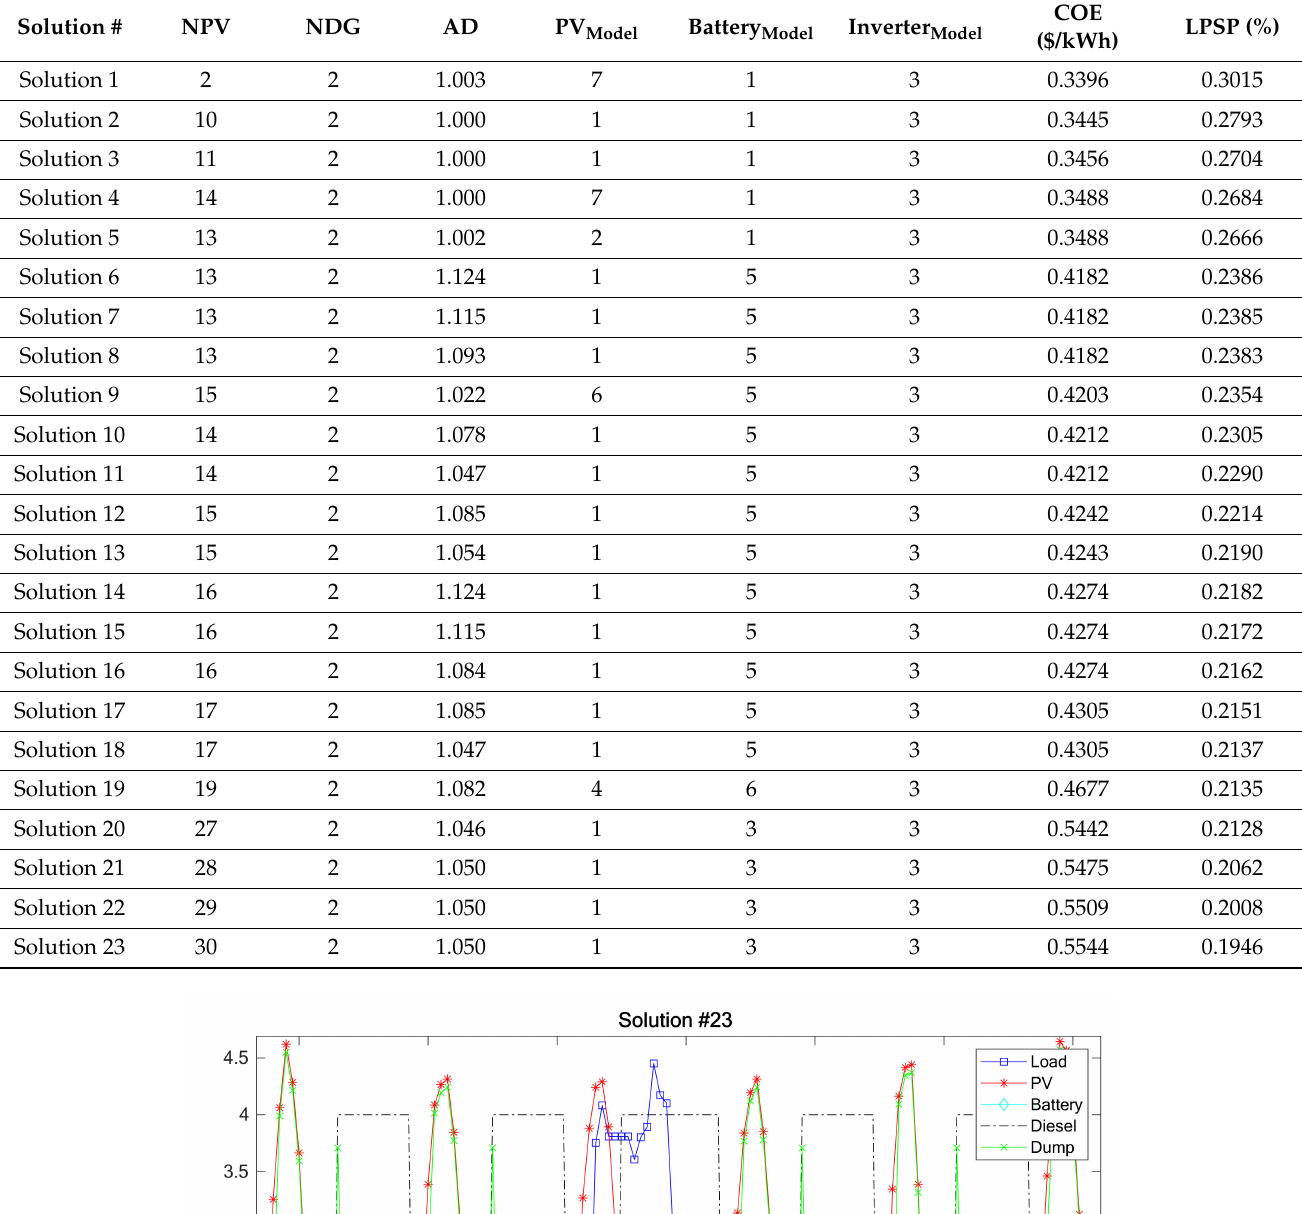
Table 2. Solutions from PF for CASE 1.